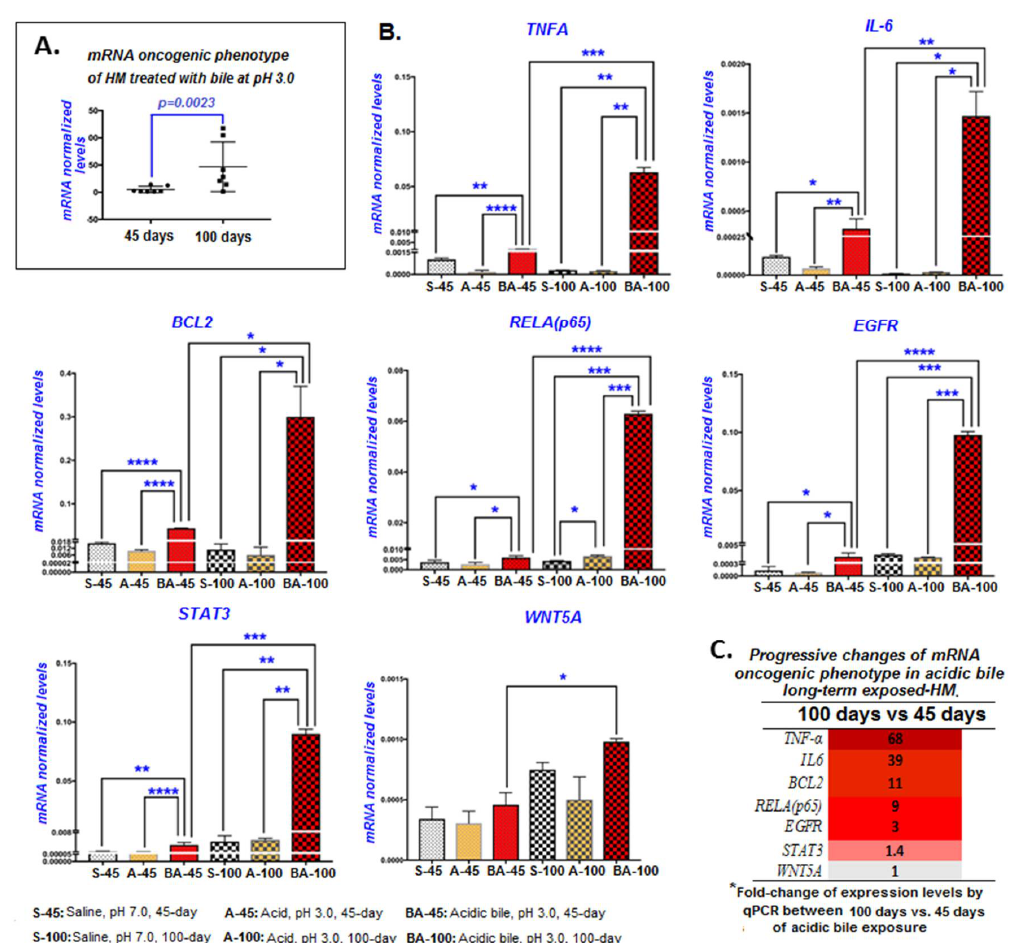
Figure 4. Progressive transcriptional activation of the NF- κ B related oncogenic phenotype. ( A ) mRNA levels of all the analyzed NF- κ B-related genes ( Bcl2 , Rela , Egfr , Wnt5a , Stat3 , Tnf , and Il6) (mRNA levels of genes normalized to Gapdh ; real-time qPCR analysis) after 45 and 100 days of exposure to acidic bile (pH 3.0) vs. the saline control. Statistical analysis reveals significantly higher mRNA ratios of the analyzed genes at 100 days vs. 45 days ( p -value using one-way ANOVA; Friedman test). ( B ) Transcriptional levels of each analyzed gene in HM exposed for 45 and 100 days to saline (pH 7.0), acid alone (pH 3.0), and acidic bile (pH 3.0) (mRNA levels of each target gene were normalized to Gapdh ; real-time qPCR analysis; Graph Pad Prism software 7.0). We observed significantly higher mRNAs in the HM exposed to acidic bile for 100 days vs. 45 days (* p < 0.01; ** p < 0.001; *** p < 0.0001; **** p < 0.00001; t -test; multiple comparisons using Holm–Sidak; GraphPad Prism 7.0; data obtained from four analyzed samples). ( C ) Progressive changes of the mRNA oncogenic phenotype (fold-change of mRNAs) at 100 days relative to 45 days.